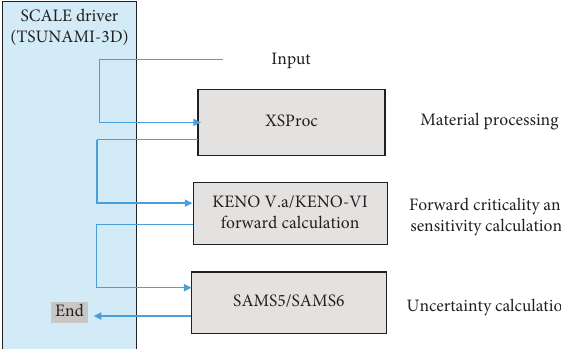
Figure 3: General flow diagram of CE TSUNAMI-3D. Table 2: Major sensitivities of k